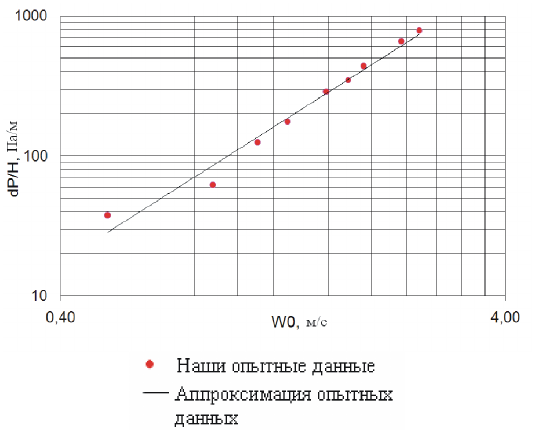
Рис. 8. График зависимости гидравлического сопро- тивления слоя насадки из колец Рашига dP / H от ско- рости воздуха W 0 , м/с.